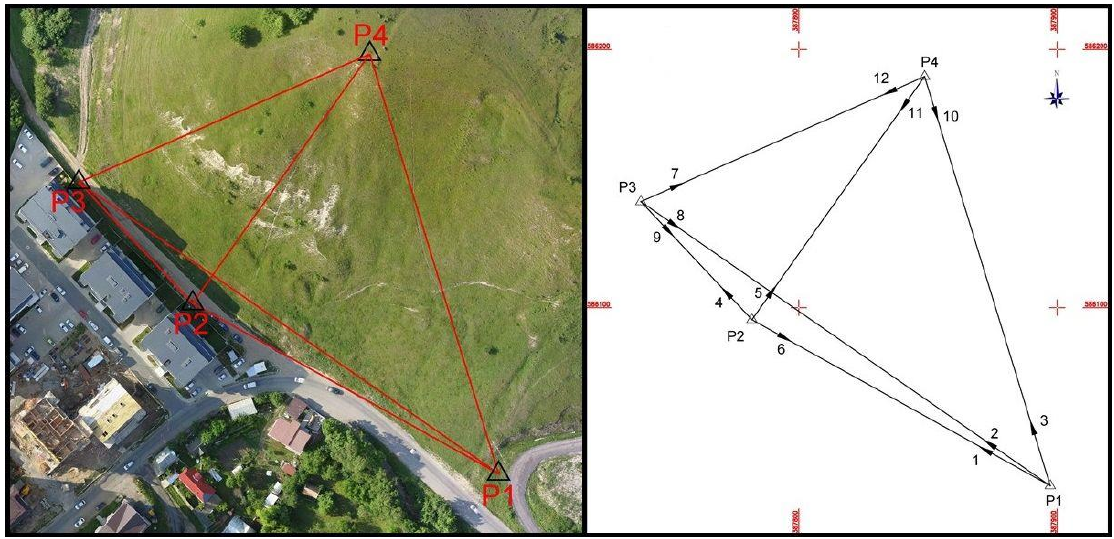
Figure 7. The four geodetic control points for slope measurement and monitoring.